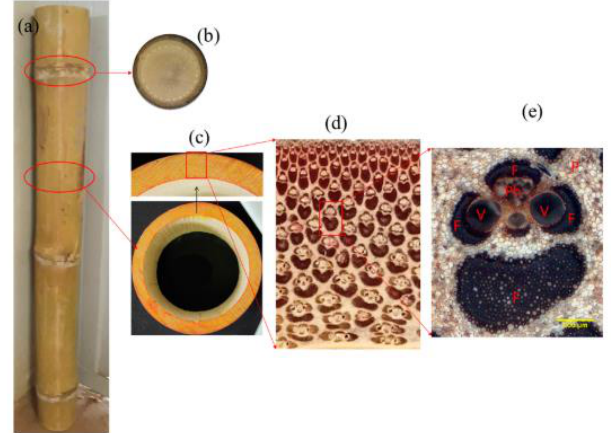
Figure 3. Morphological characteristics of bamboo: ( a ) bamboo culm; ( b ) node diaphragm; ( c ) inter- node; ( d ) culm wall; and ( e ) vascular bundle [69].